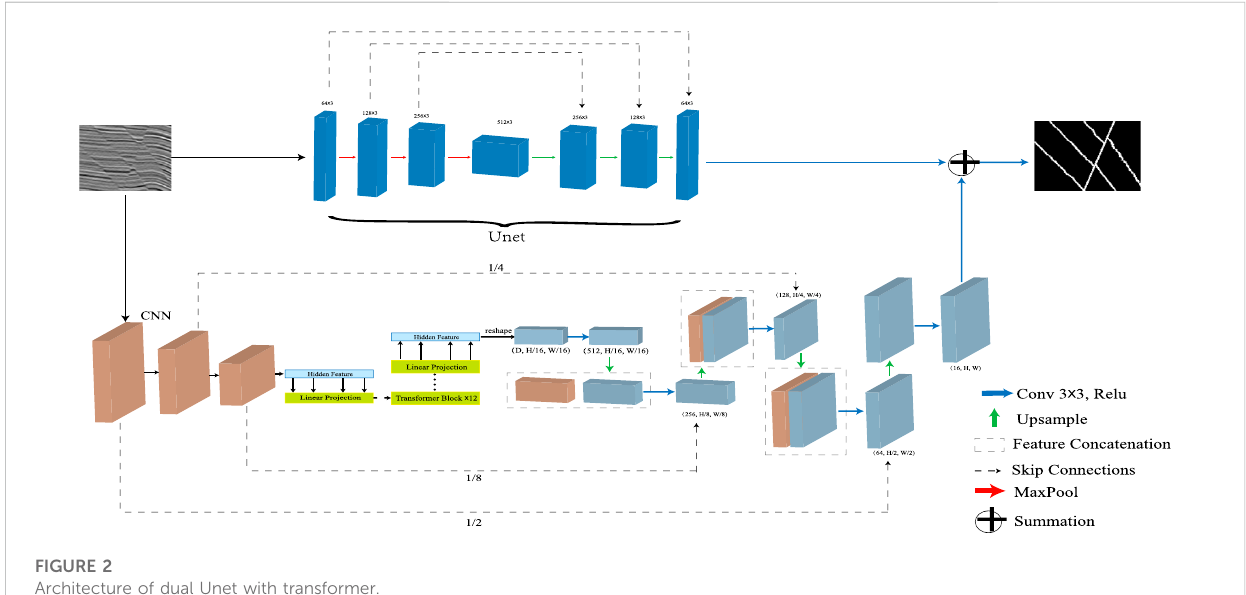
FIGURE 2 Architecture of dual Unet with